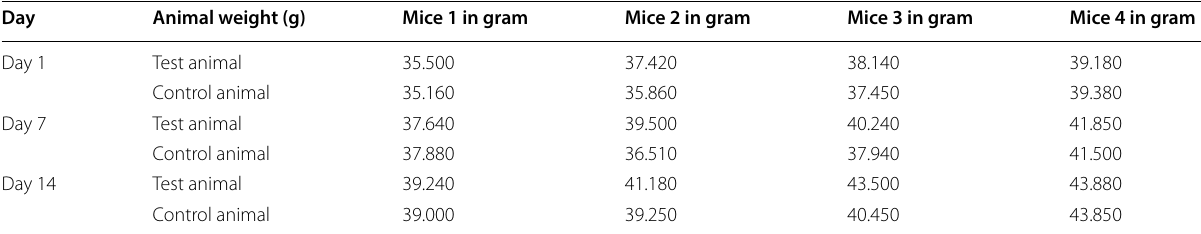
Table 6 Experimental weight of animals that were recorded within fixed time interval Day Animal weight